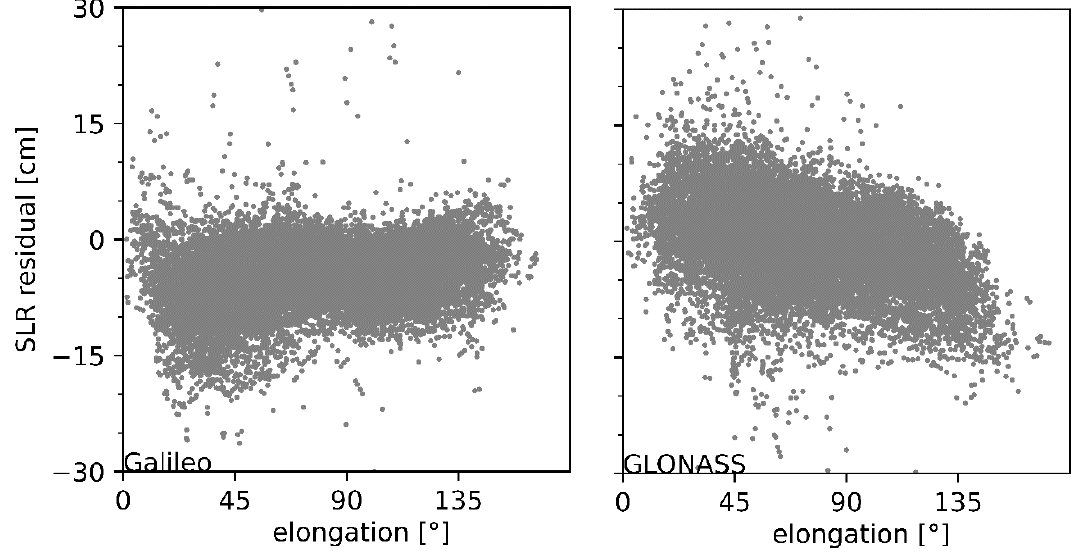
Figure 12. SLR residuals of Galileo ( left panel ) and GLONASS ( right panel ) orbits as a function of satellite elongation angle.